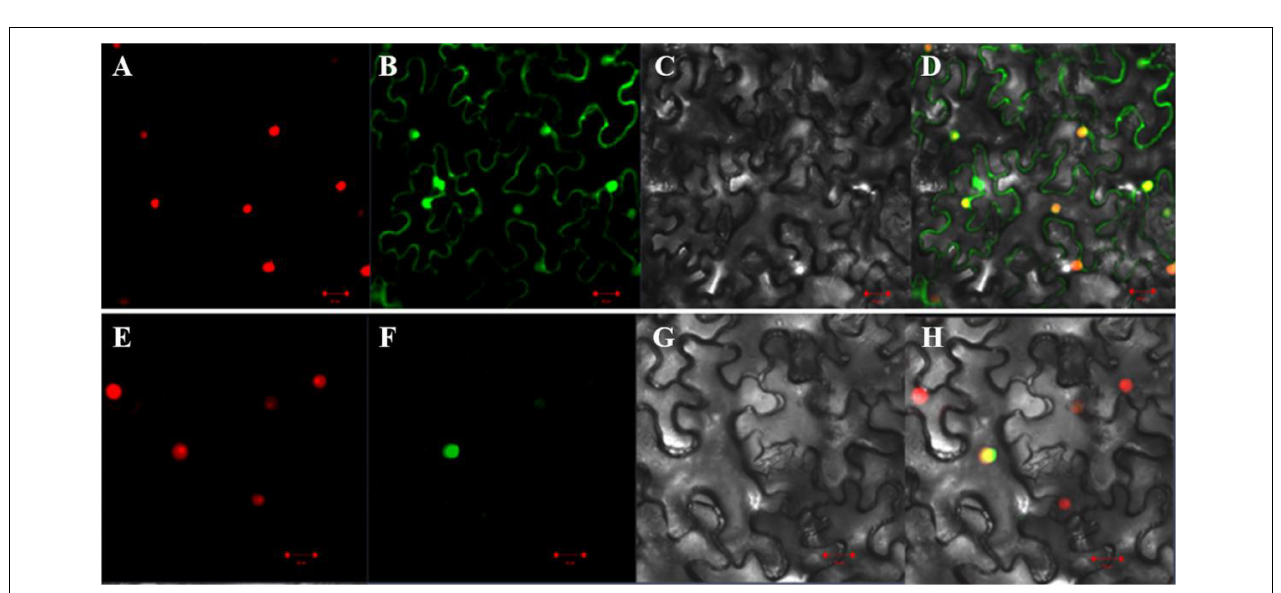
FIGURE 4 | Reverse-transcription quantitative PCR analyses of expression of six representative soybean GmAP2/ERF144 genes during increasing time of drought and gene expression pattern in different soybean tissues. (A) Reverse-transcription qPCR analyses of the expression of six representative genes in the GmAP2/ERF family during drought stress treatment. Leaves of two-week-old soybean plants were collected for analysis when watering was stopped for 0, 2, 4, 6, and 8 d. (B) Tissue expression pattern of gene GmAP2/ERF144 . Values are the mean ± SE. ∗ p < 0.05; ∗∗ p < 0.01 (Student’s t -test).